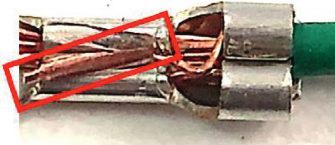
Figure 4: Wire strands lose.